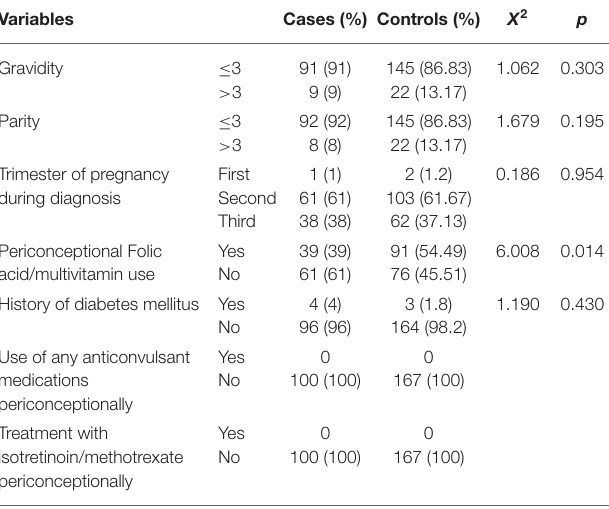
TABLE 2 | Pregnancy and disease conditions of the study participants in three selected hospitals in Addis Ababa, Ethiopia, between September 2019 and